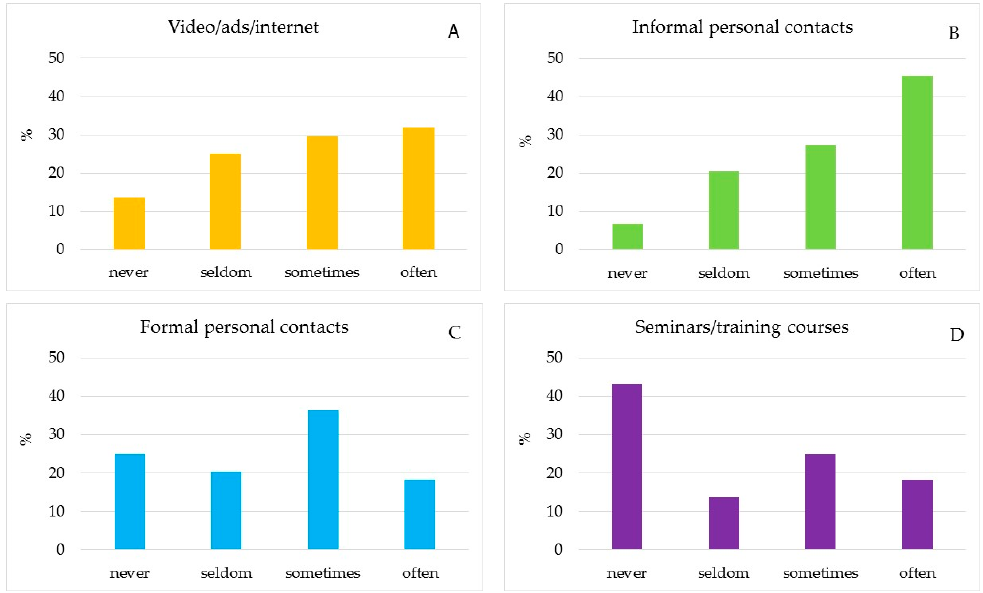
Figure 2. Percentages of responses on the frequency of use of the different information sources: ( a ) videos/ads/internet; ( b ) informal personal contacts (neighbors, other farmers); ( c ) formal personal contacts (farmers’ association, consultants); ( d ) seminars/training courses.